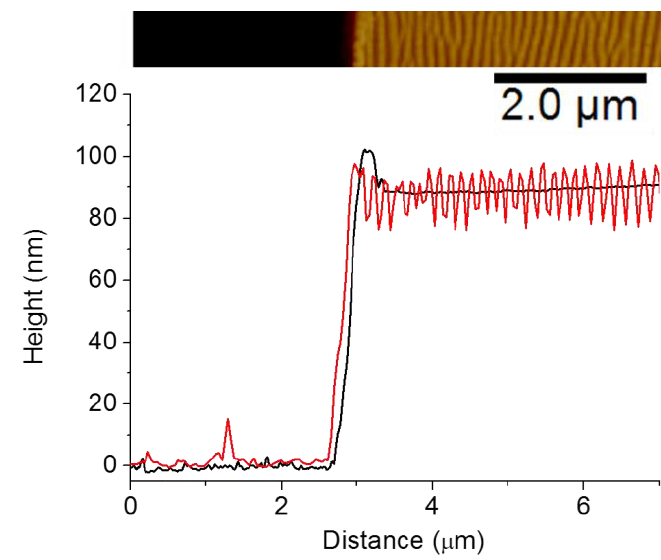
Figure 9. Height profiles of the spot central part after removal with a razor blade part of: PC 71 BM film irradiated at λ laser = 266 nm (3600 pulses, F = 9.0 mJ/cm 2 ) (red line) and initial spin-coated PC 71 BM film (black line). The upper inset shows the AFM height image of the LIPSS sample where the profile was calculated. The darker zone on the left corresponds to the part which has been removed by the razor blade.